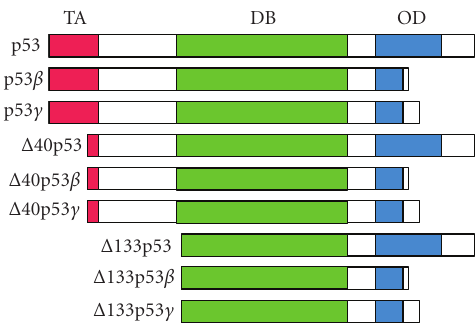
Figure 2: Schematic diagram of p53 variants. TA: transactiva- tion domain; DB: sequence-specific DNA-binding domain; OD: oligomerization